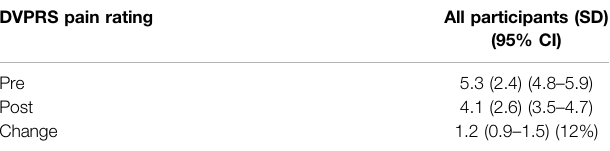
TABLE 1 | Cohort characteristics. TABLE 2 | Effect on pain (DVPRS 0 –